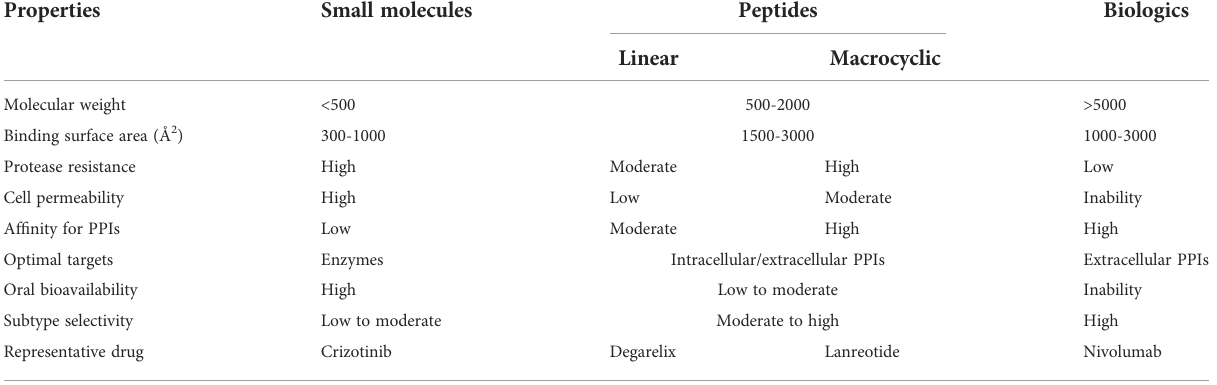
TABLE 3 The difference among three major classes of therapeutic molecules.